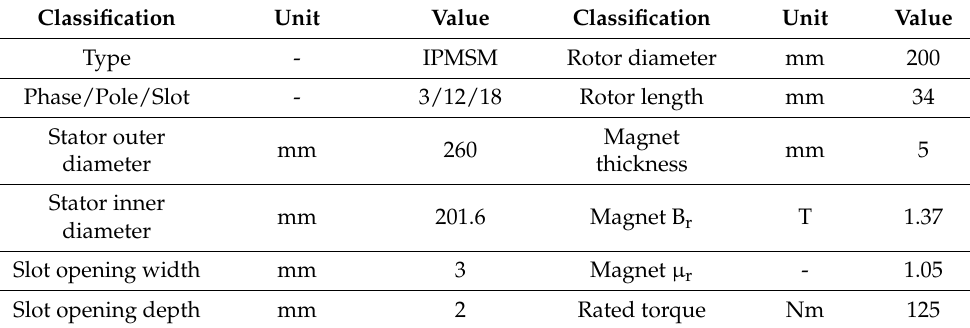
Table 5. Design specifications of the in-wheel